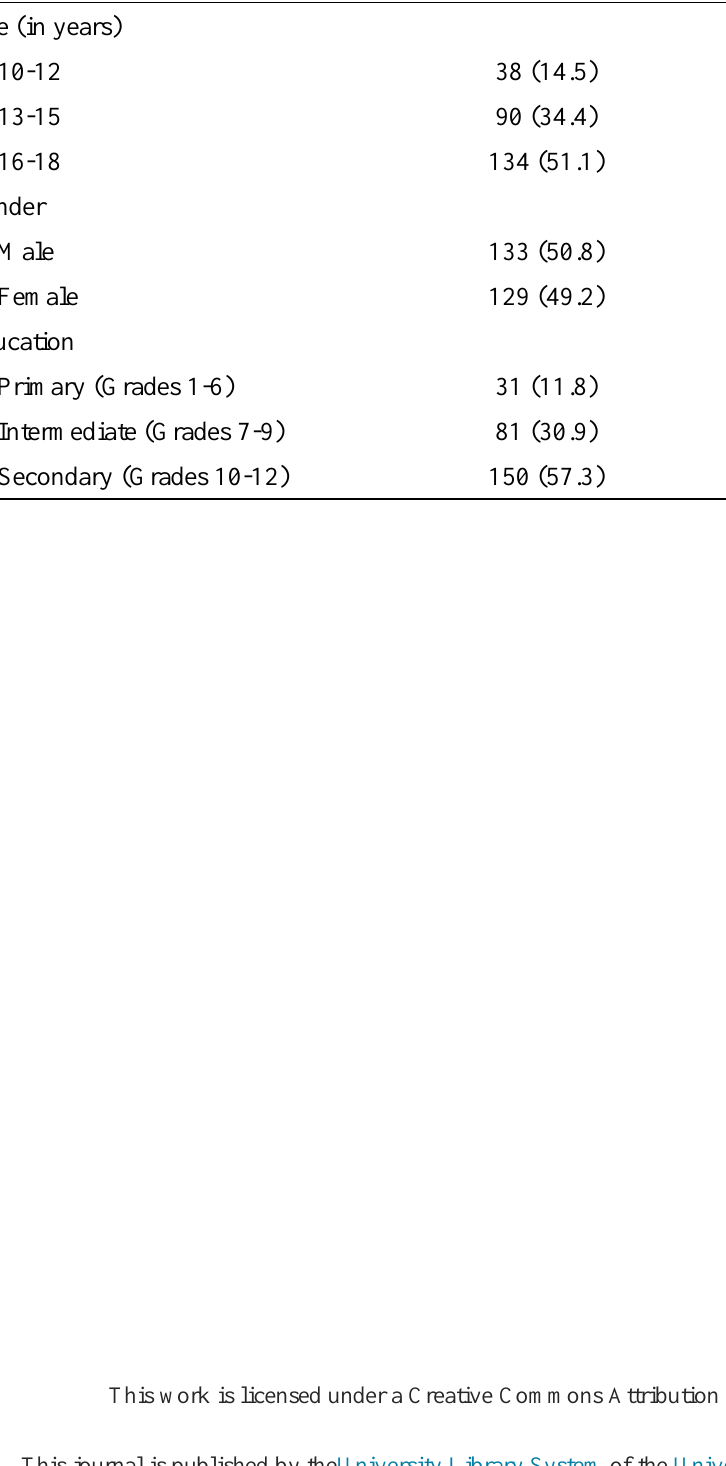
Table 1: Qualitative demographic characteristics of participants